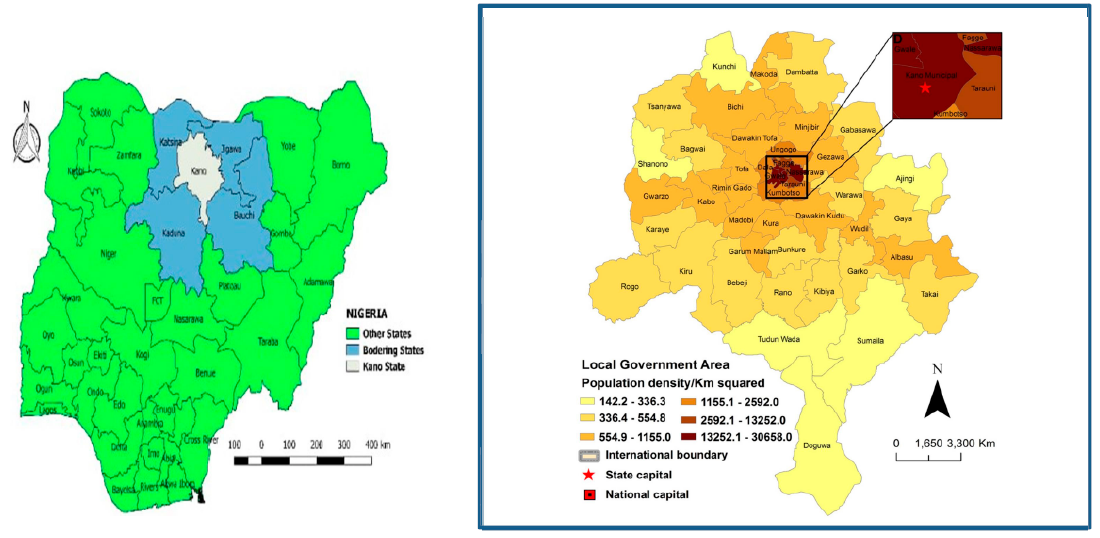
Figure 1. The Nigerian Map shows Kano State (light blue) and an enlarged map of Kano State showing population density, study areas, and the state capital, Kano Municipal Local Government Area.